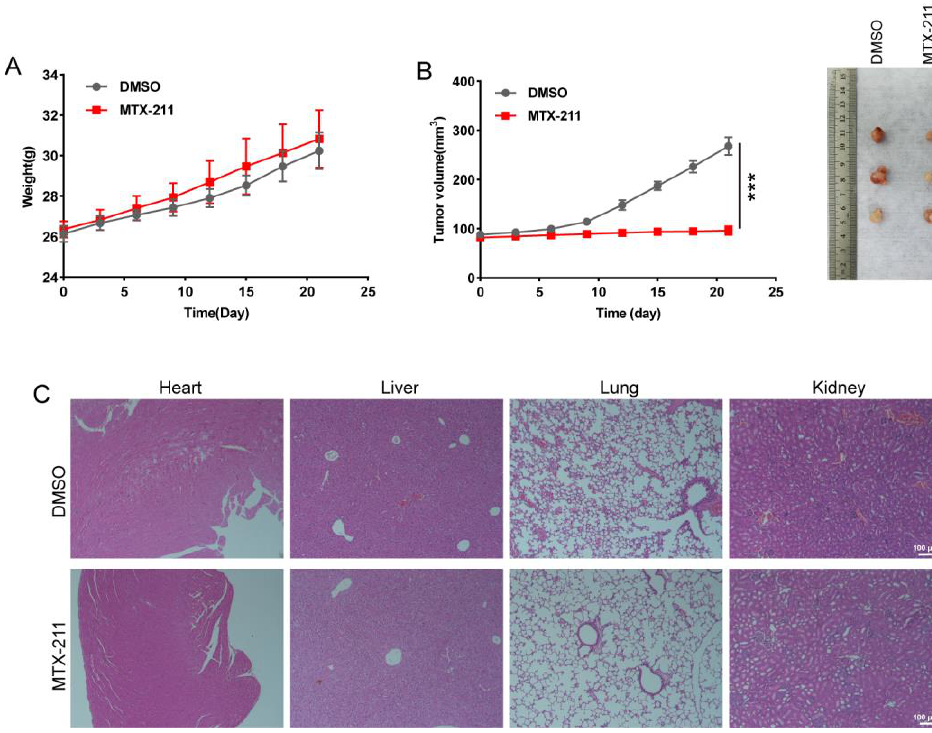
Figure 6. MTX-211 treatment inhibits the growth of the xenograft tumor. ( A ) The body weight of nude mice in DMSO- and MTX-211-treated groups. ( B ) The tumors were harvested and imaged at day 21 post-MTX-211 treatment. ( C ) Hematoxylin – eosin staining revealed that MTX-211 did not exert toxic effects on the organs of mice. *** p < 0.001. Scale bar: 100 μm .